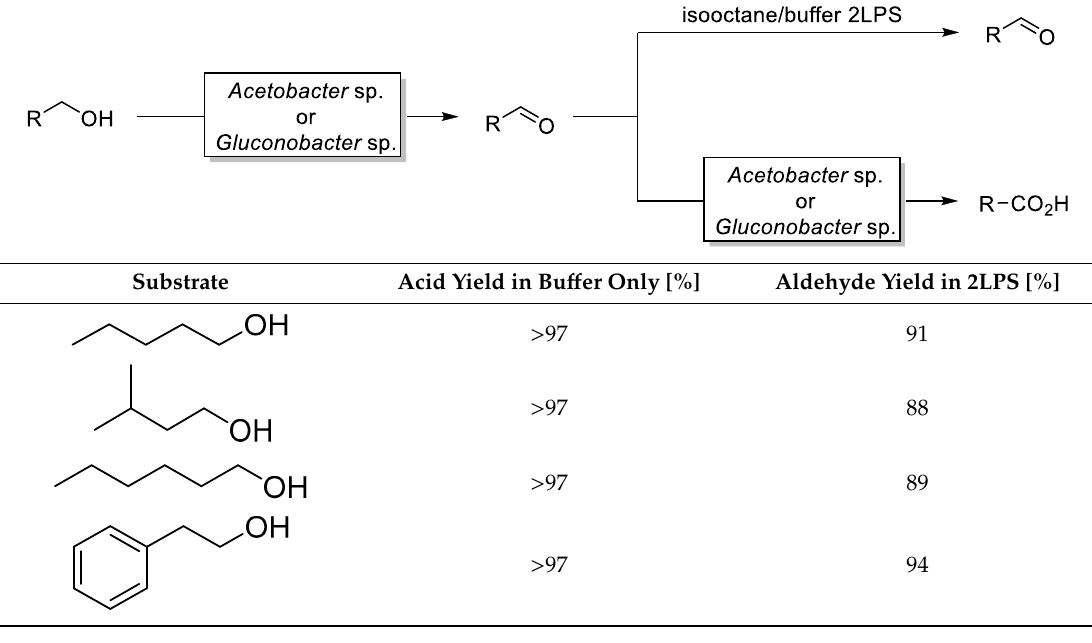
Table 2. Controlling the selectivity of the whole-cell catalyzed oxidation of primary alcohols.